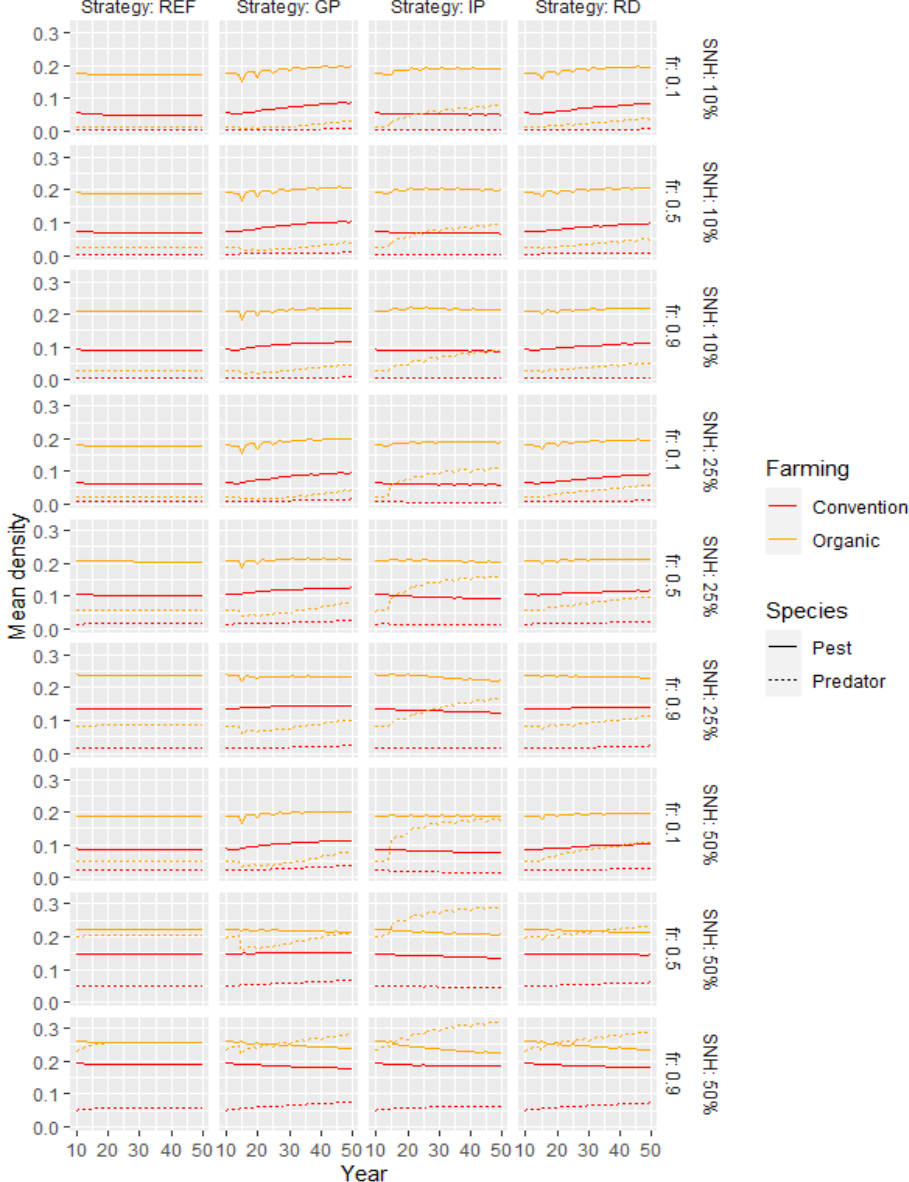
Figure 3 - Effect of organic expansion scenarios on the temporal evolution of the mean density of pests and predators in organic (OF) and conventional farming (CF), as a function of fragmentation ( fr ) and initial proportion of semi-natural habitat (SNH). Reference (REF) represents the absence of organic